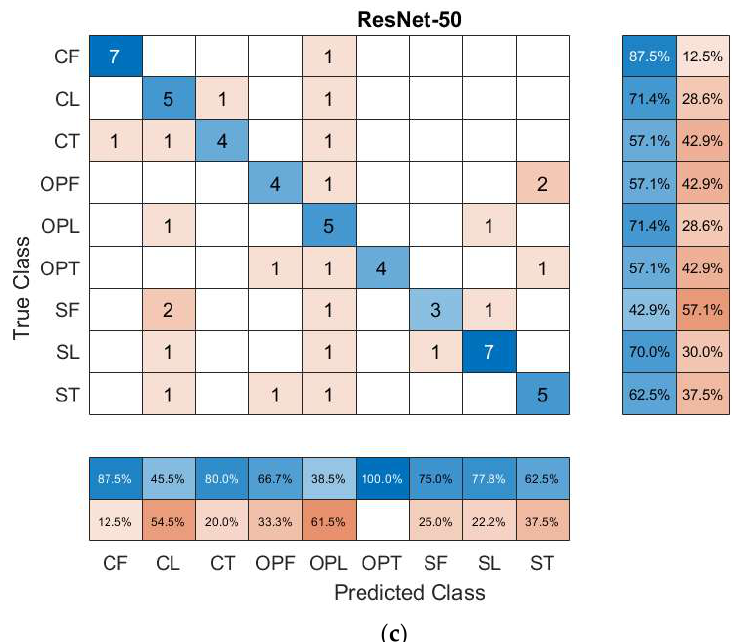
Figure 10. Confusion matrix of predictions made by TL on ( a ) SqueezeNet; ( b ) AlexNet; ( c ) ResNet-50.